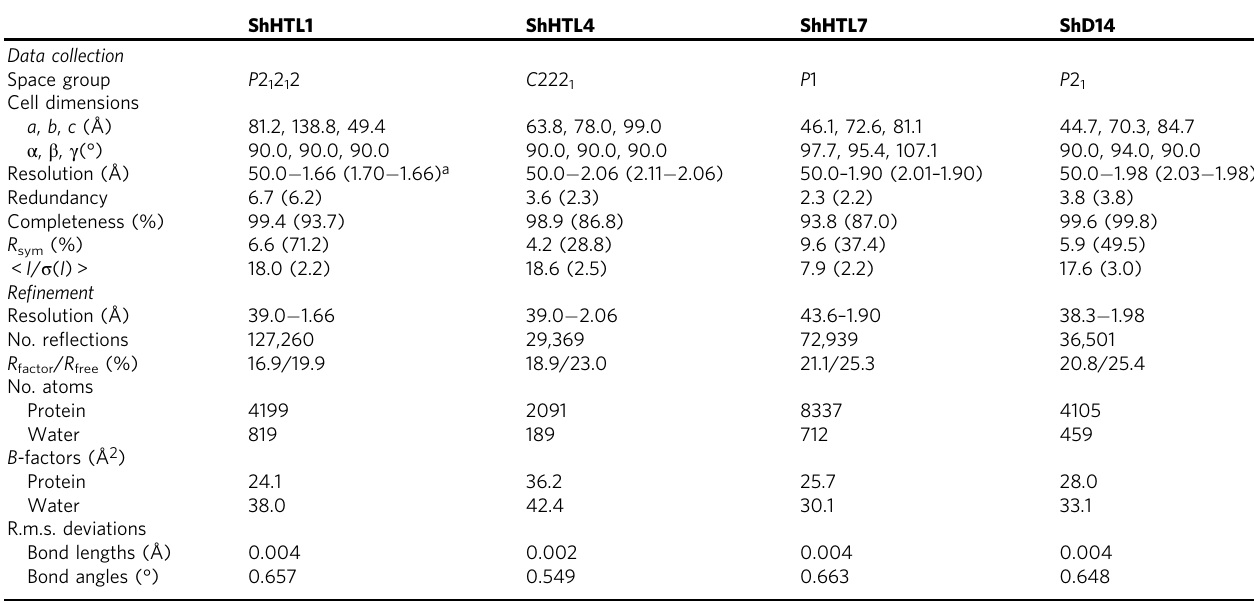
Table 1 X-ray data collection and re fi nement